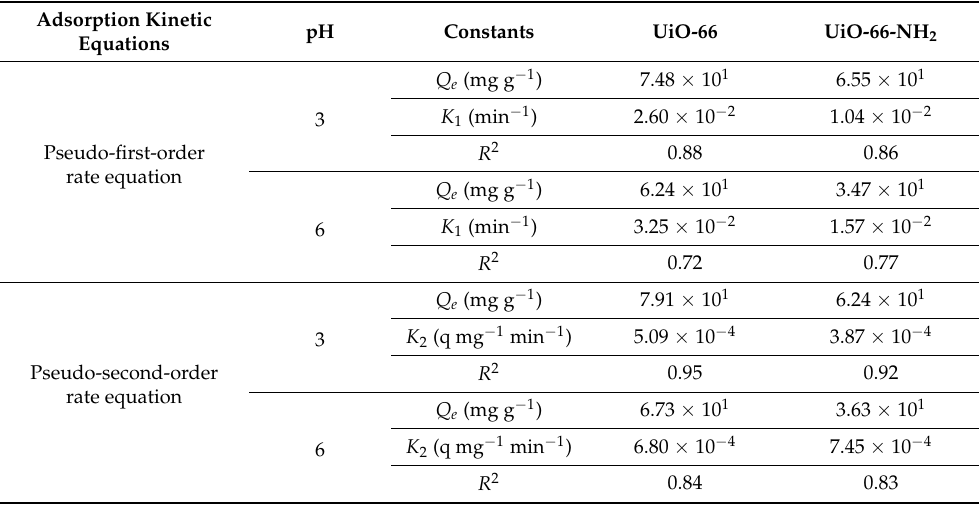
Table 2. Adsorption kinetics parameters of pseudo-first- and pseudo-second-order kinetic equations for TCs on UiO-66 and UiO-66-NH 2